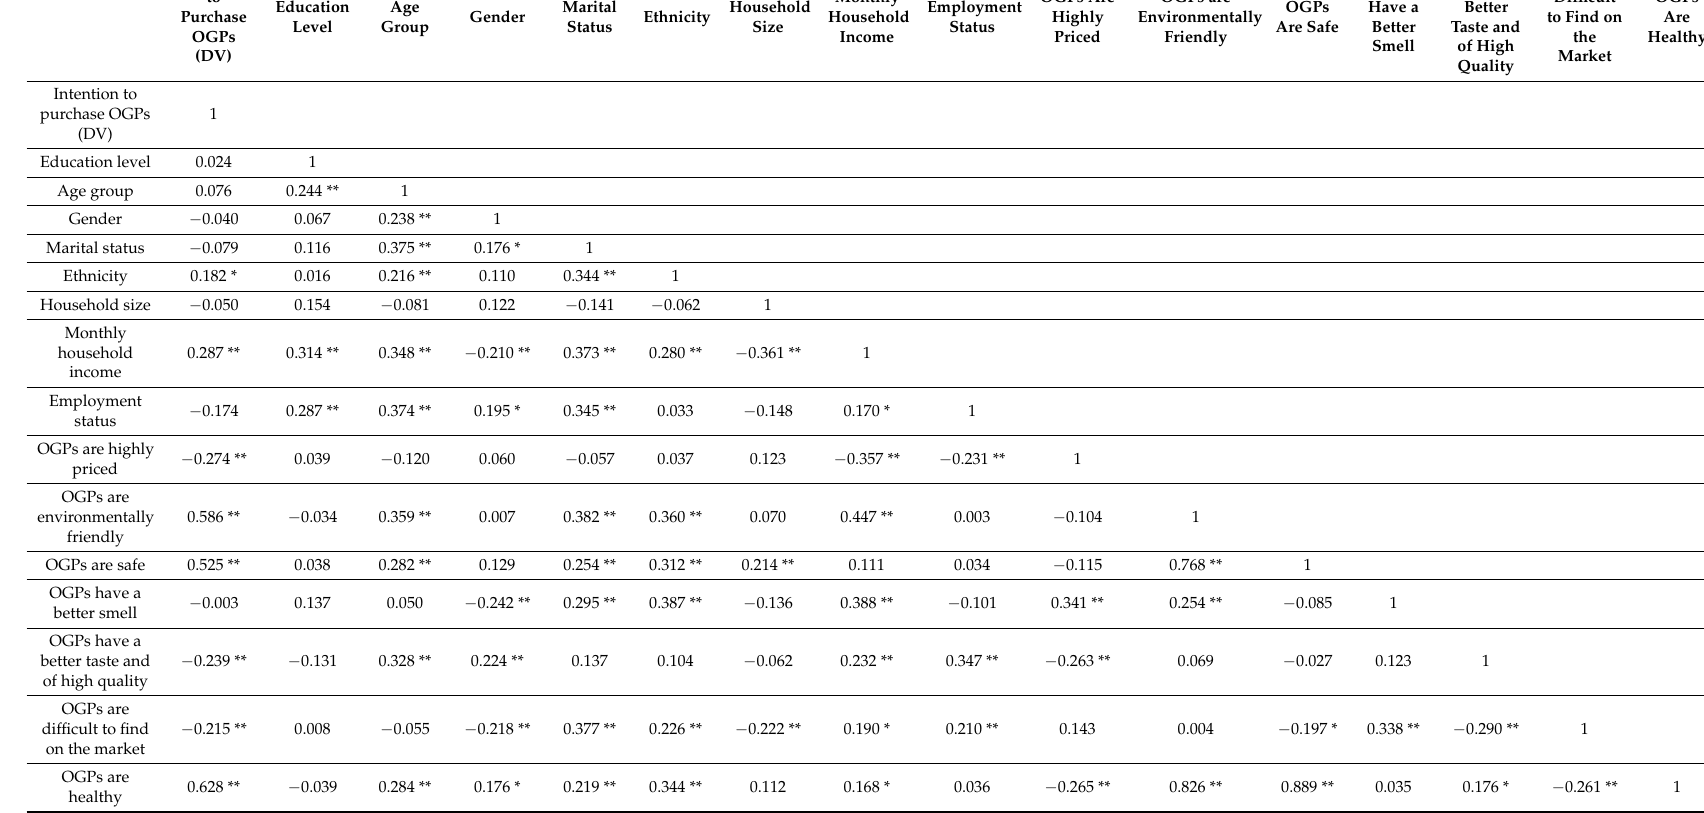
Marital Status Ethnicity